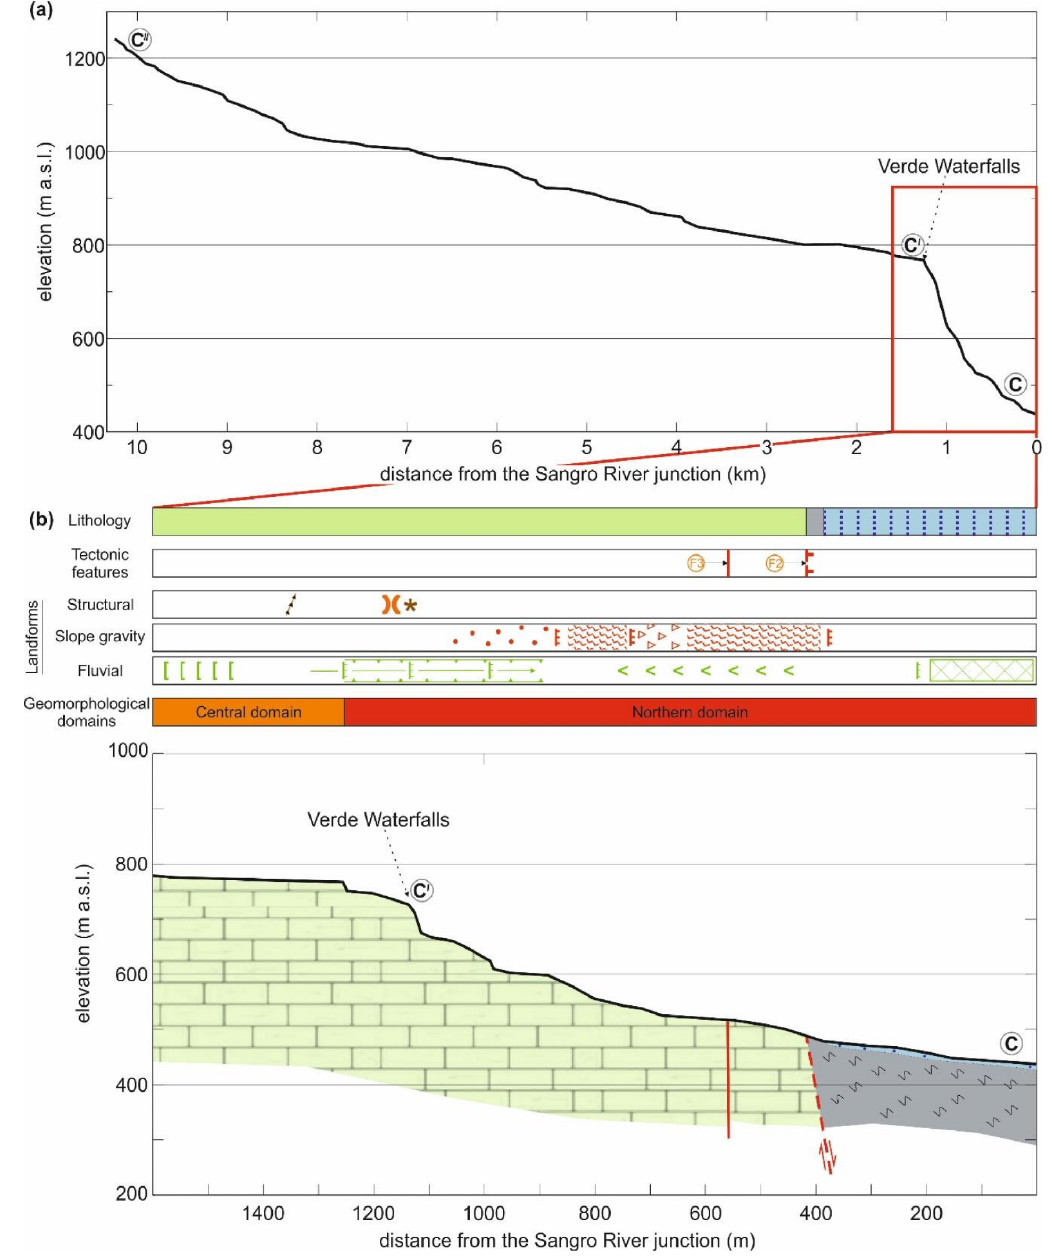
Figure 15. ( a ) The Verde Stream’s long profile; ( b ) geomorphological section of the northern reach of the Verde Stream’s long profile (red box); location in Figures 1–14 (letters C, C’,